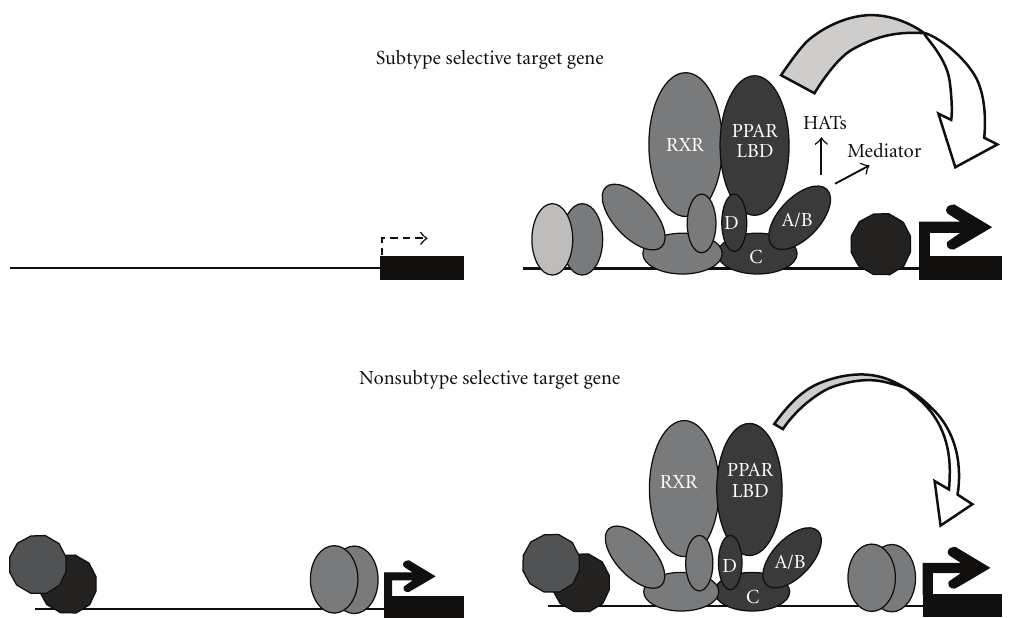
Figure 1: The PPAR A/B-domains potentiate transactivation of the highly subtype selective target genes. Illustration of the di ff erential requirement for the PPAR A/B-domains in the transactivation of highly subtype selective and non-subtype selective target genes. The PPAR subtype specific target genes are generally expressed at very low levels in the absence of PPARs, but expression is dramatically increased upon introduction of full length exogenous PPAR. The activities of the PPAR A/B-domains are necessary to obtain this potent induction of the highly subtype specific target genes, presumably by facilitating recruitment and tethering of histone acetylase complexes (HATs) and the Mediator complex. Conversely, non-subtype selective PPAR target genes are usually already expressed at high levels in the absence of PPARs, and their expression levels are only increased by a few fold in response to ectopic PPAR expression. The PPAR A/B-domains appear to be dispensable for transactivation of this group of target